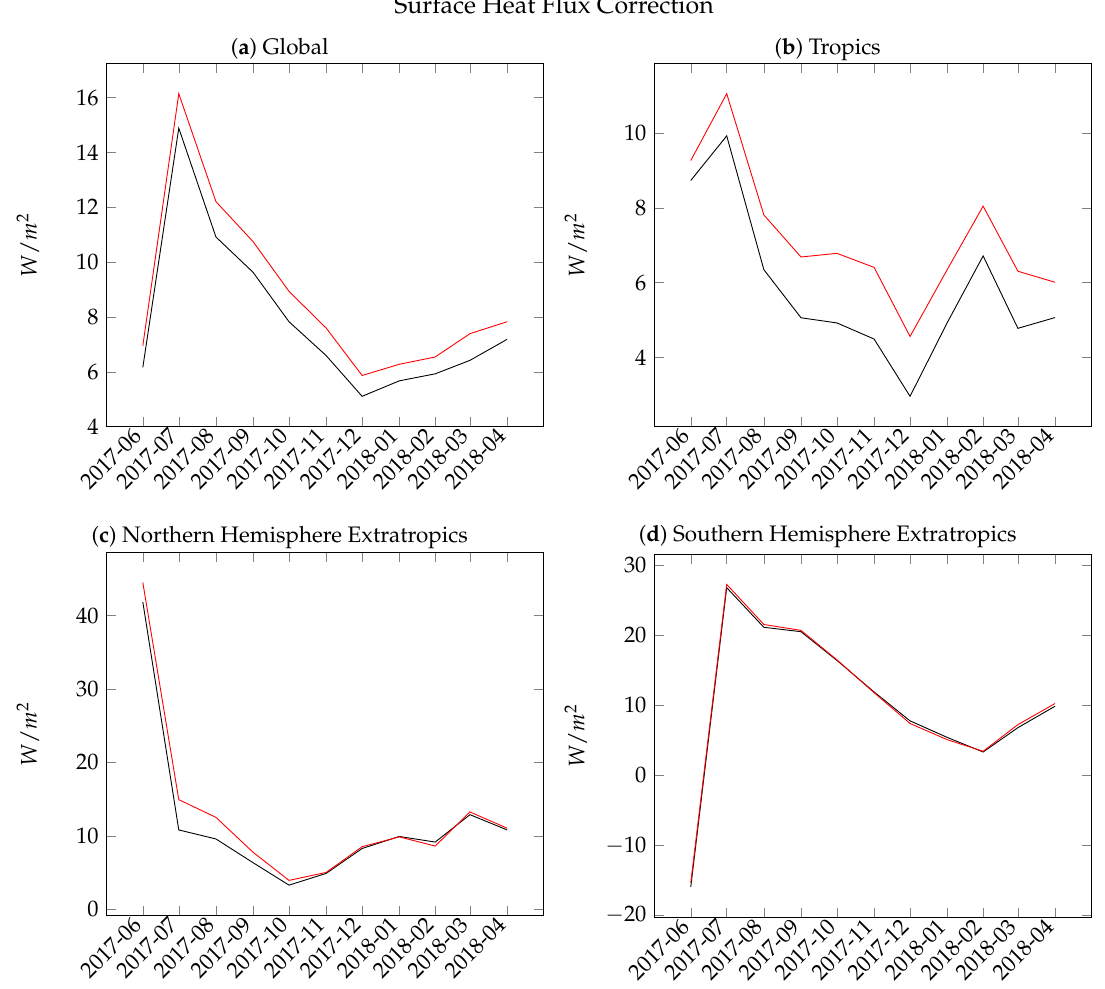
Figure 11. Monthly averaged ocean heat flux correction from the uncoupled analysis (red) and the weakly coupled analysis (black). This is split by region showing global ( top left ), the tropics ( top right ), the northern hemisphere extratropics ( bottom left ) and the southern hemisphere extratropics ( bottom right